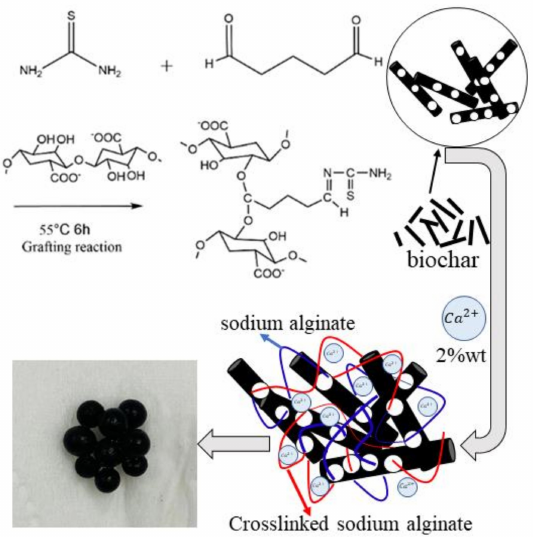
Figure 14. Schematic diagram of material